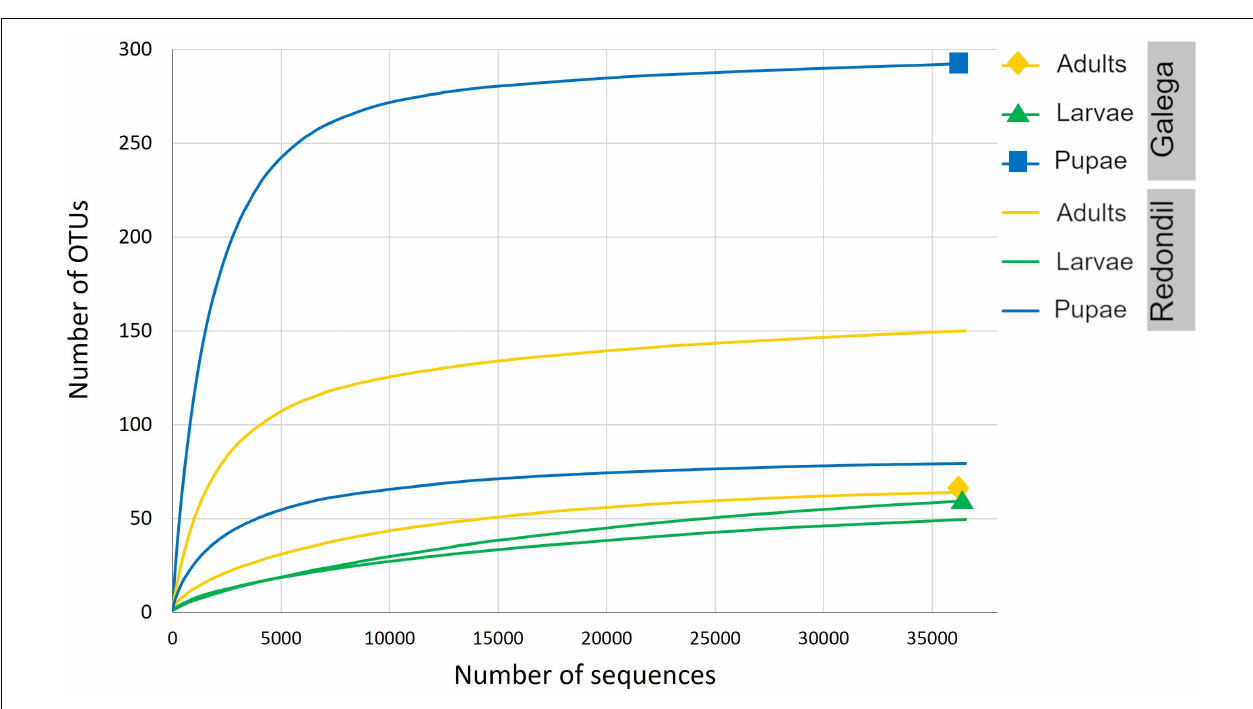
larvae, 41 in the pupae, and 21 in the adults), Propionibacterium sp. (56 records in the larvae, 376 in the pupae, and 252 in the adults), and Corynebacterium spp. (2 OTUs; 6 records in larvae,